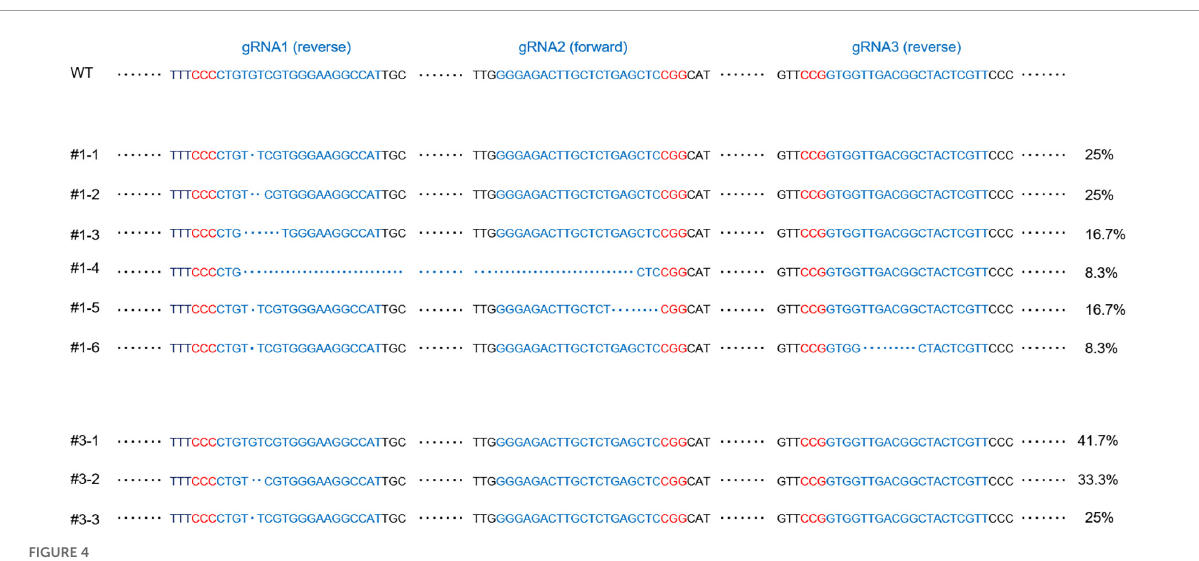
FIGURE4 Short and long deletion sequence variants detected in T1 transgenic plants. The sequences of the unmodified locus for gRNA1, gRNA2, and gRNA3 in WT are labeled along the top. gRNA target sites are in blue and PAM sequences are in red. The deletions from T1 transgenic plants #1 and #3 are listed below WT, with generated deletions to gDNA represented by blue dots. #1-1 to #1-6 and #3-1 to #3-3 represent the different PCR products from plant #1 and #3, respectively. The appearance ratios of corresponding sequences in the screening of PCR products are indicated on the right. #3-1 shows no edits on all three gRNA target sites. No fragments like WT or #3-1 were detected in transgenic line #1.